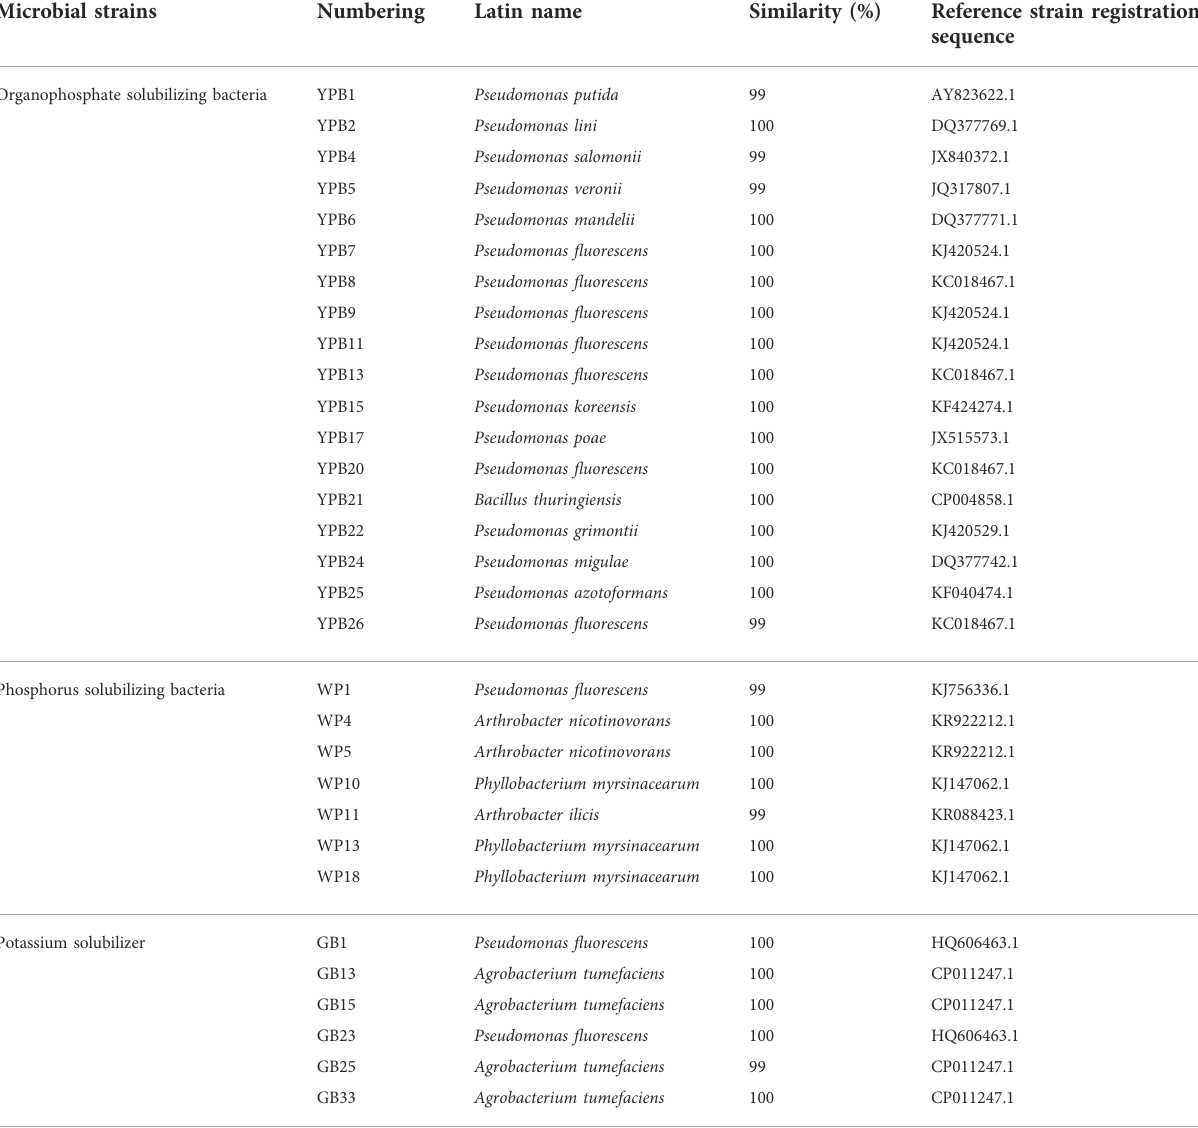
TABLE 1 Diversity of potassium solubilizing bacteria and phosphate solubilizing bacteria in the rhizosphere of Fritillaria L. medicinal plants. Microbial